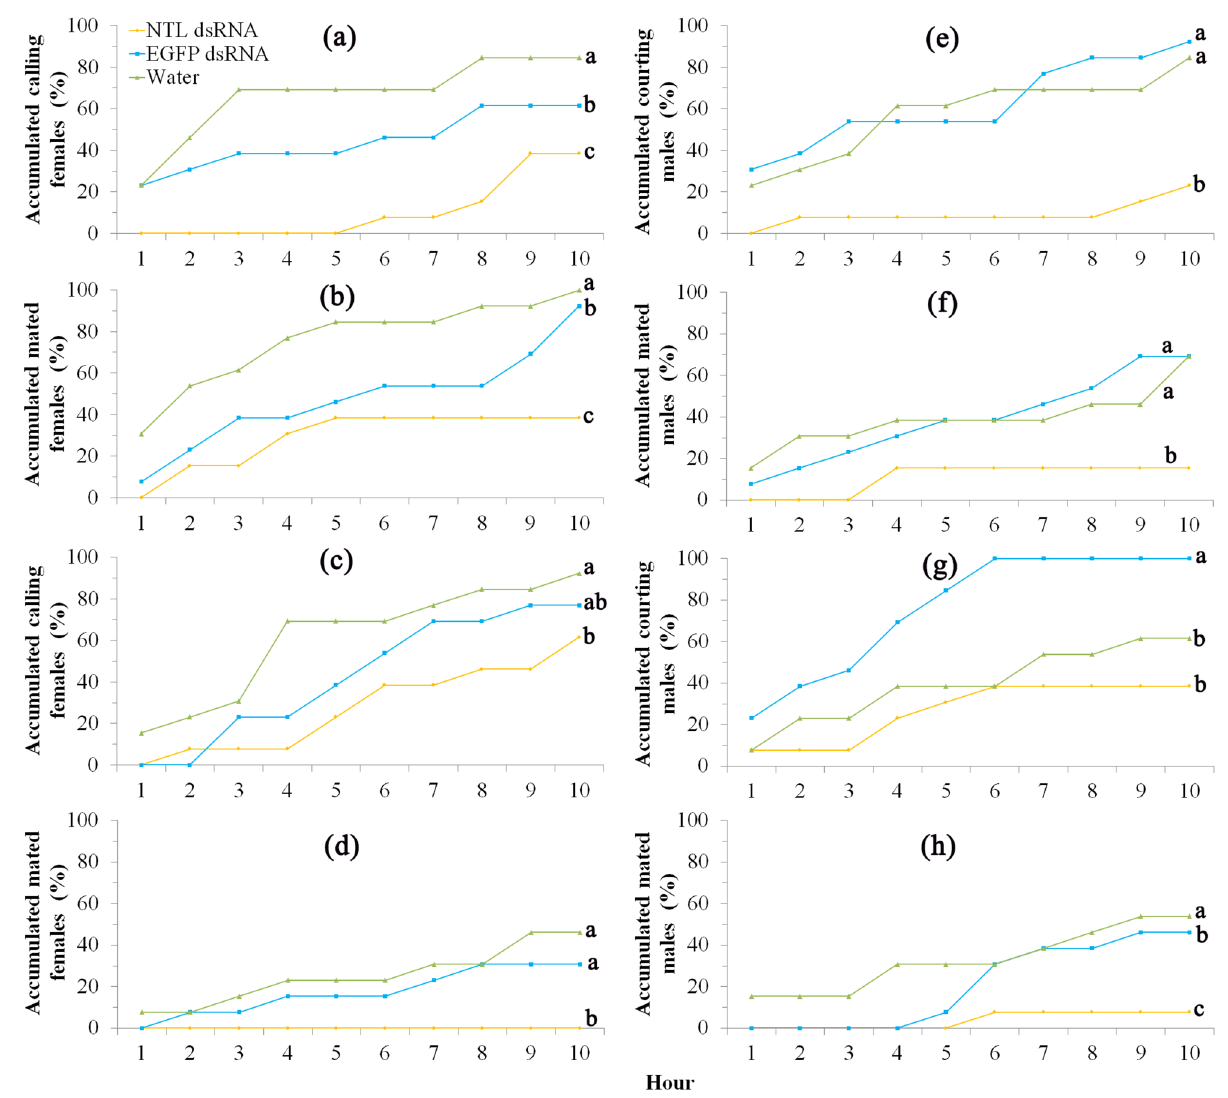
Figure 4. Effects of NTL RNAi on female (a-d; treated females paired with untreated males; thirteen pairs were used, i.e., n = 13) and male (e–h; treated males paired with untreated females; also thirteen pairs were used, i.e., n = 13) reproductive behavior in the first two days after pairing. Female calling behavior in the first ( a ) and second ( c ) scotophase. Female mating behavior in the first ( b ) and second ( d ) scotophase. Male courtship behavior in the first ( e ) and second ( g ) scotophase. Male mating behavior in the first ( f ) and second ( h ) scotophase. Data were not normally distributed even after transformation and thus were analysed using the nonparametric Kruskal–Wallis test followed by Dunn’s procedure for multiple comparisons. For each parameter, i.e., in each of the subgraphs, lines with different letters are significantly different ( P <